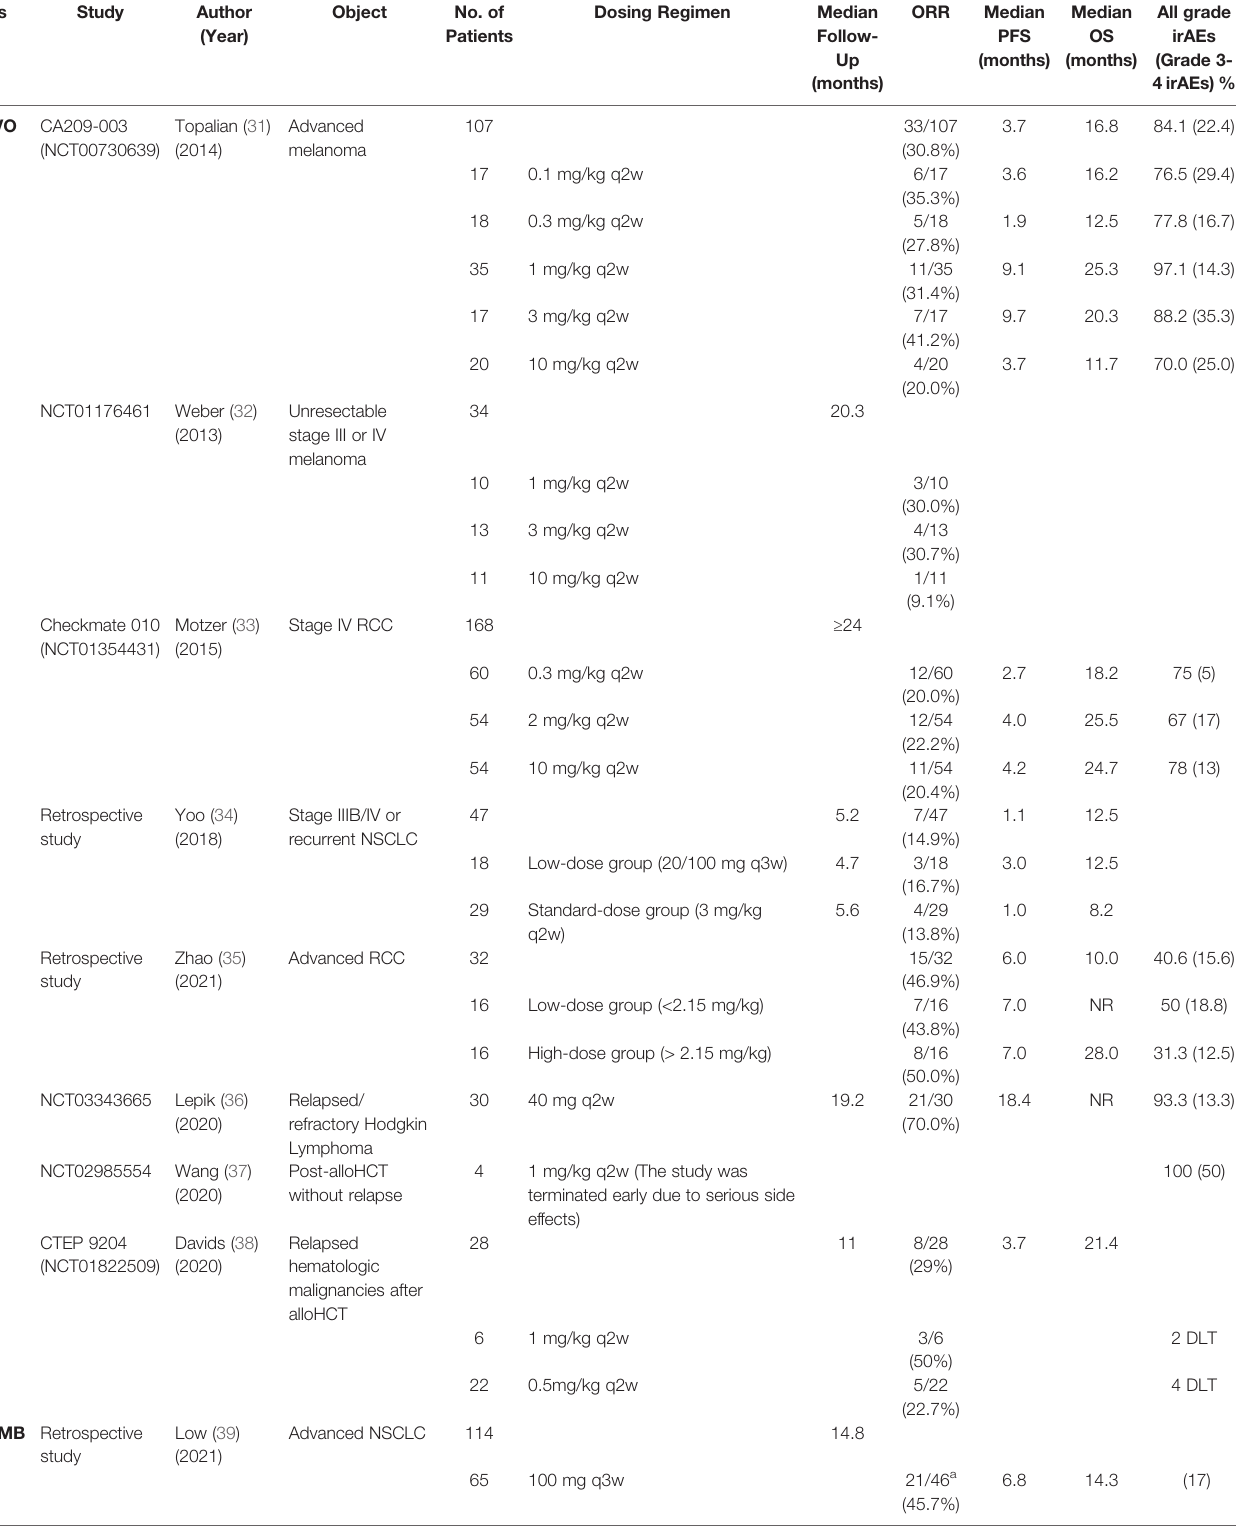
TABLE 1 | Retrospective and Prospective Studies of Dose Reduction of